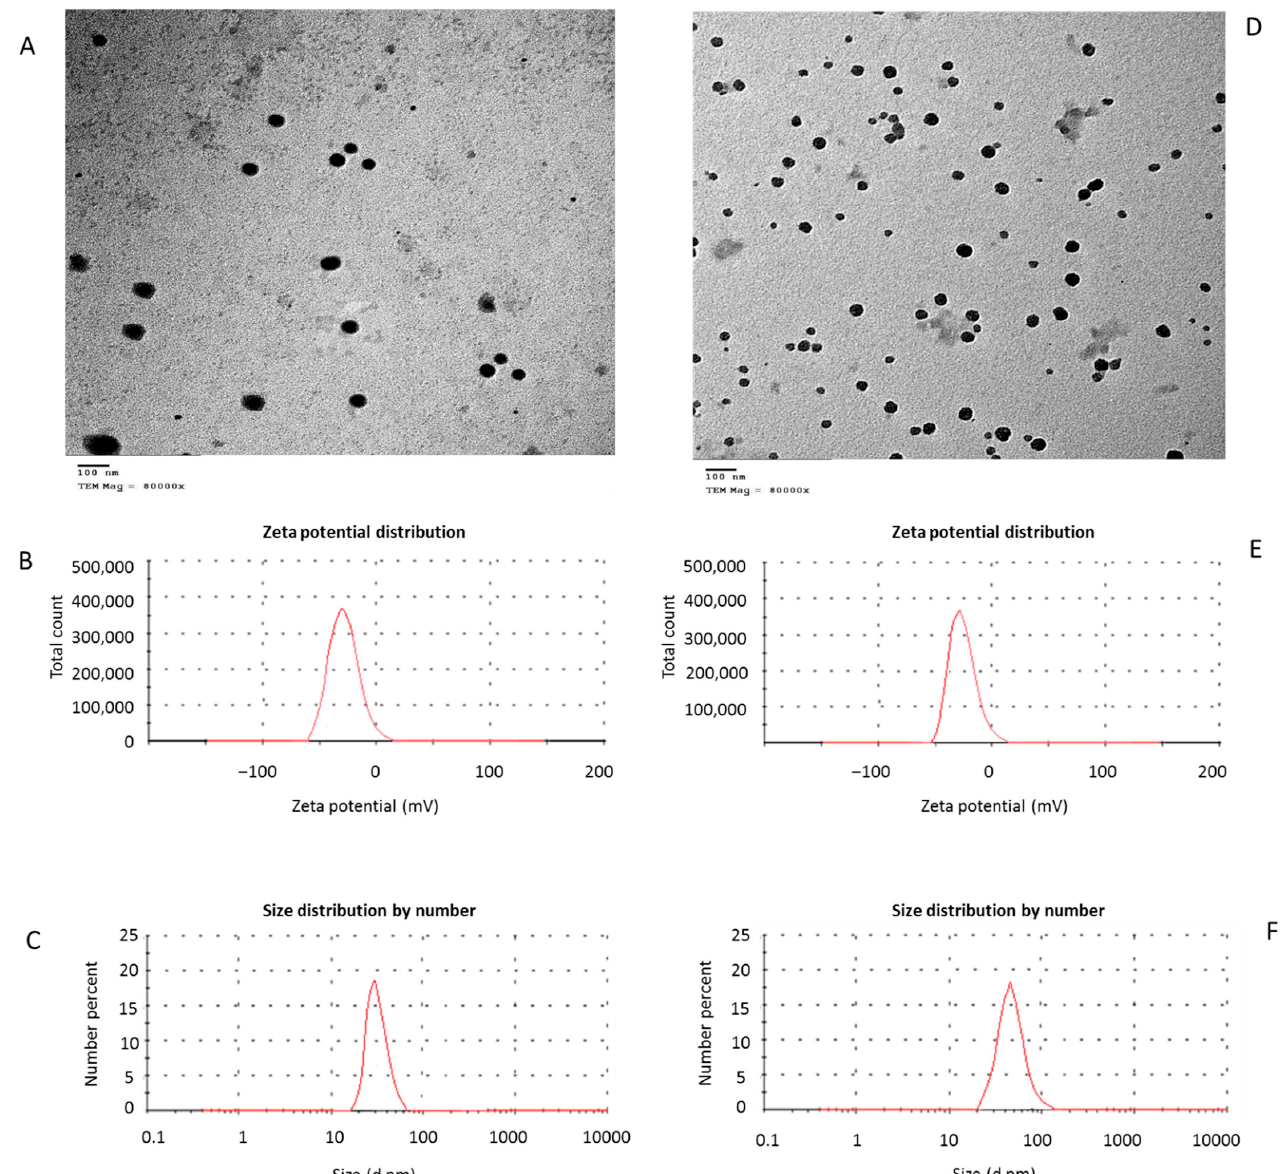
Figure 1. Characterization of zinc nanoparticles (ZnNPs) and curcumin nanoparticles (CurNPs); ( A – C ) shape, charge, and size of ZnNPs accessed by TEM, zeta potential, and zeta sizer, respectively. ( D – F ) shape, charge, and size of CurNPs accessed by TEM, zeta potential, and zeta sizer, respectively.